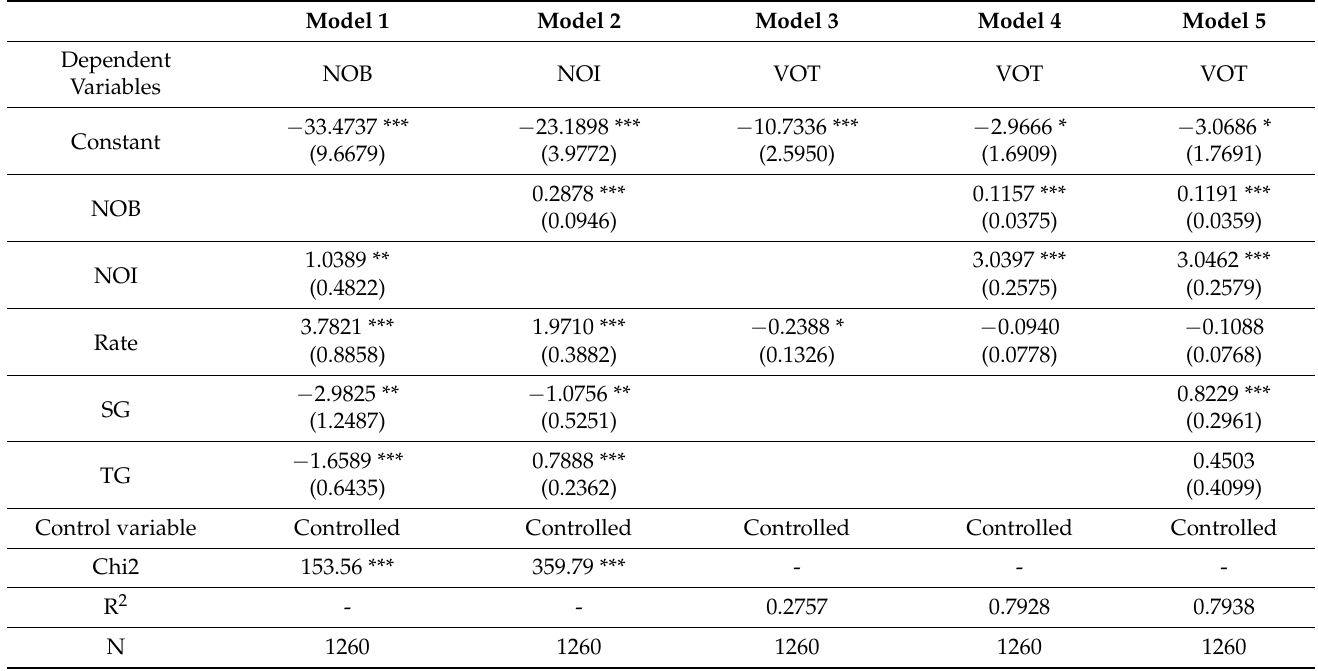
Table 9. Model regression